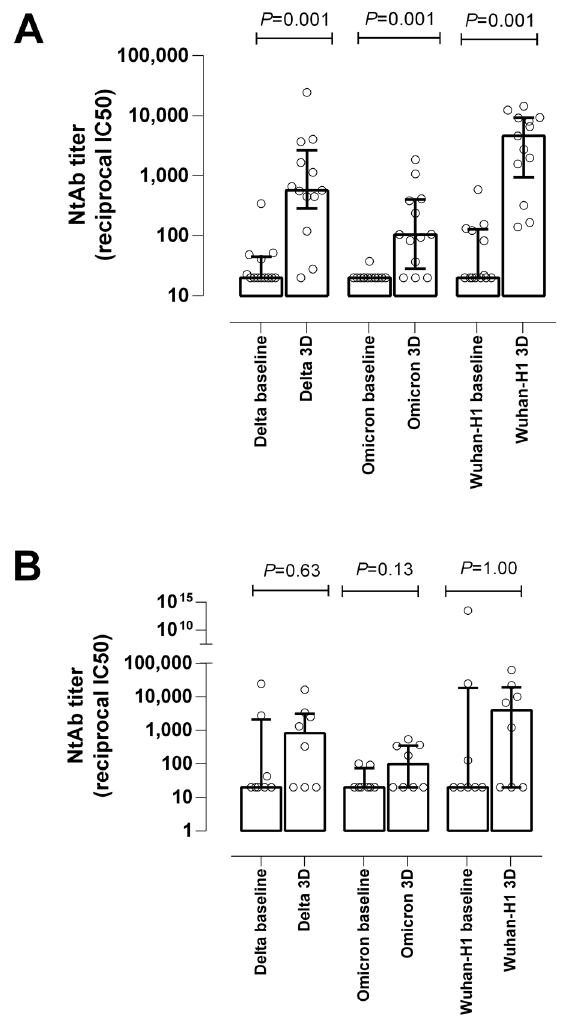
Figure 3. Box and whisker plot depicting the neutralizing antibody (NtAb) levels (reciprocal IC 50 titer) against the ancestral Wuhan-Hu-1, Delta, and Omicron variants in ( A ) hemodialysis patients (HD) and ( B ) kidney transplant recipients after receipt of a homologous mRNA COVID-19 third dose (3D) relative to those measured at baseline; p -values for comparisons across groups are shown.